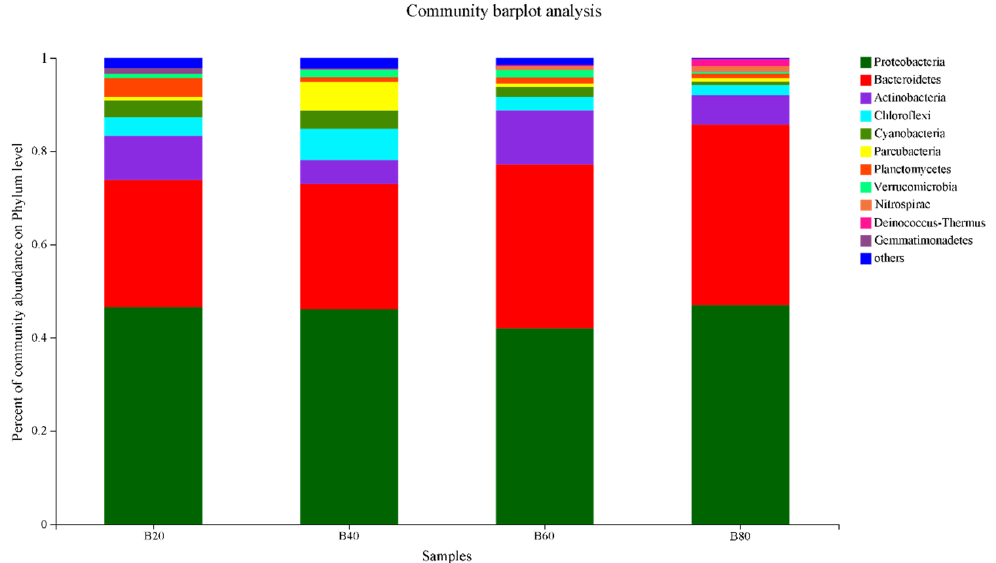
Figure 4. component abundances at the phylum level of four